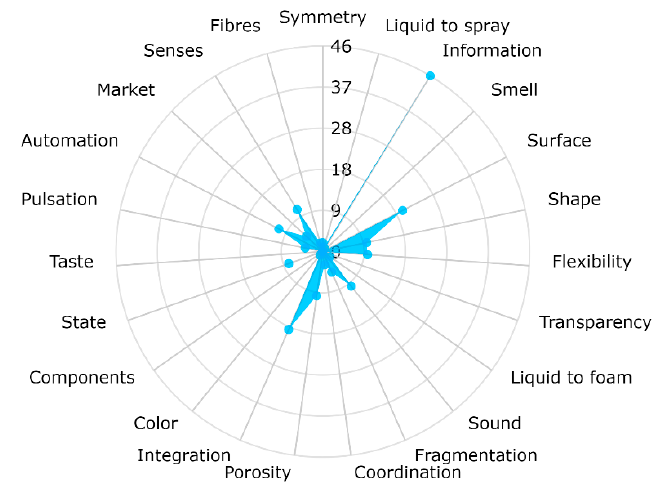
Figure 6. Evolutionary Potential analysis of the patent pool of the “Smart Furniture” phrase in Title, Abstract, Claims and Description for all years (1999–2018).